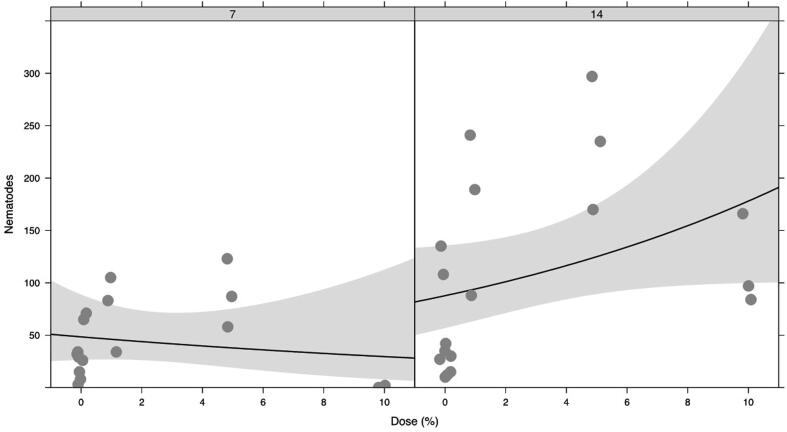
Dose-response curves for behavioural responses of M. hapla following treatment with VOC (granular formulation of 1-octen-3-ol) and assessed 7 and, 14 days post treatment. Fitted lines show log-linear responses. Shaded ribbons show 95% confidence envelopes.